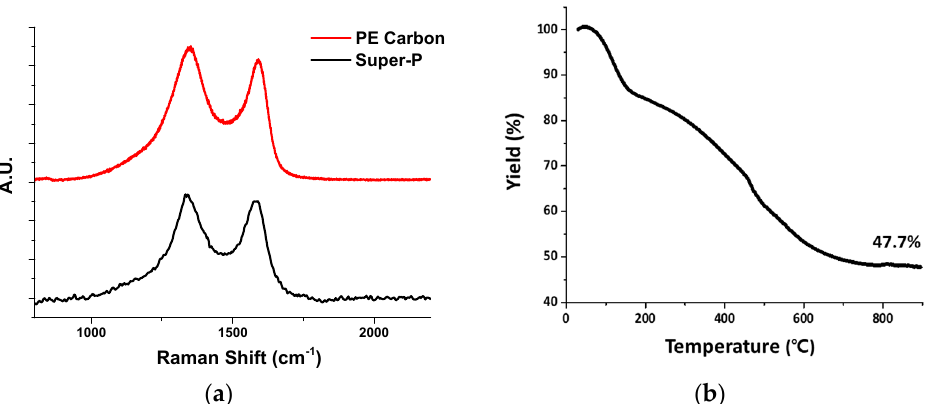
Figure 4. ( a ) Raman spectra of carbon derived from sulfonated PE (PE carbon) and SuperP. ( b ) Thermogravimetric analysis (TGA) results for sulfonated PE.